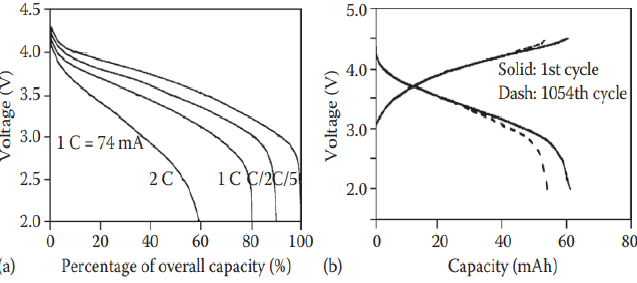
Figure 7. ( a ) Discharge curves for various rates and ( b ) charge/discharge curves in different cycles for the gel lithium-ion batteries (74 mAh) fabricated by Ultralife Co. Ltd